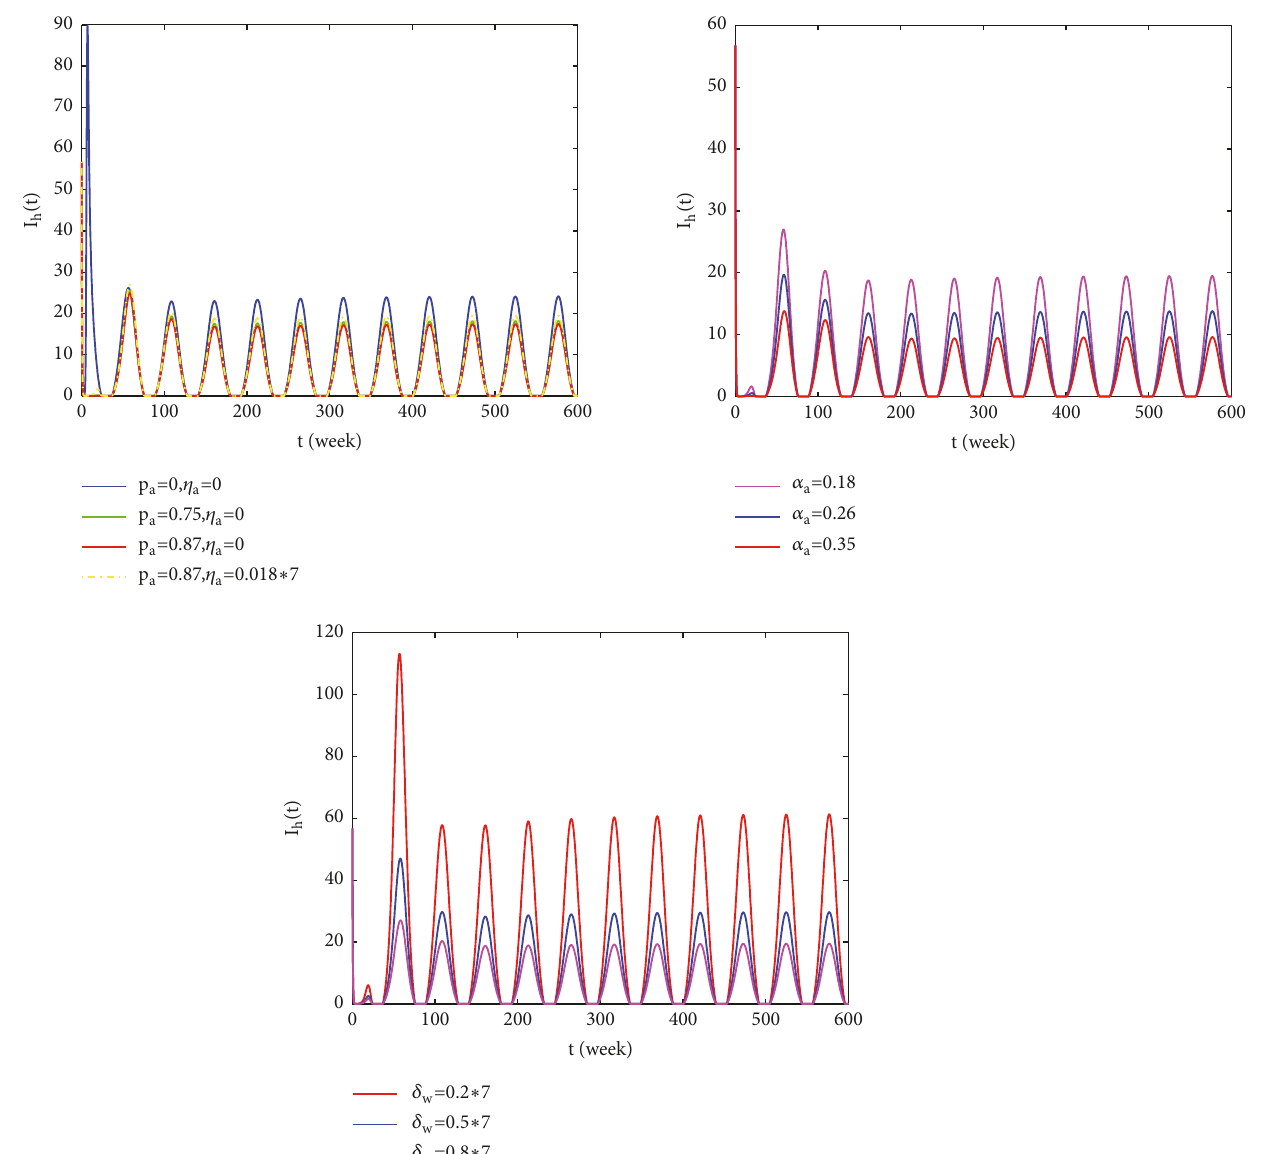
Figure 9: The curve-trend diagram of 𝐼 ℎ with time, when parameters take different